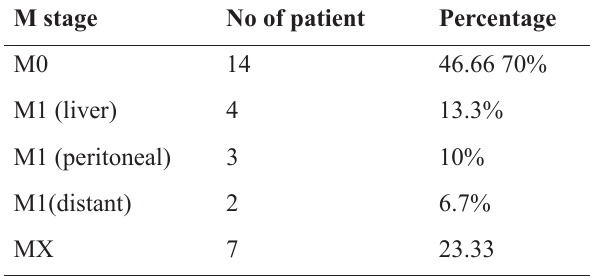
Table 5: Metastasis (M stage) M